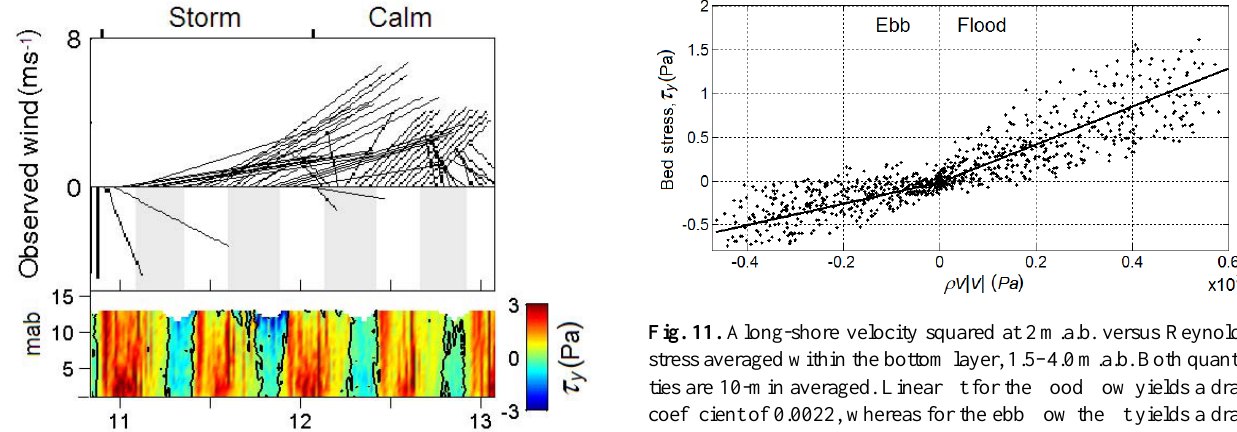
Fig. 9. Time-depth variations of the Reynolds stresses (a) τ x (Pa) and (b) τ y (Pa), (c) log 10 P (Wm − 3 ) and (d) log 10 A z (Wm − 3 ) obtained from the variance method and corrected with VF method (Appendix B). The sea surface level (SSH) is shown in the upper panel. Zero-stress components (panels a, b ) are marked by solid black lines.